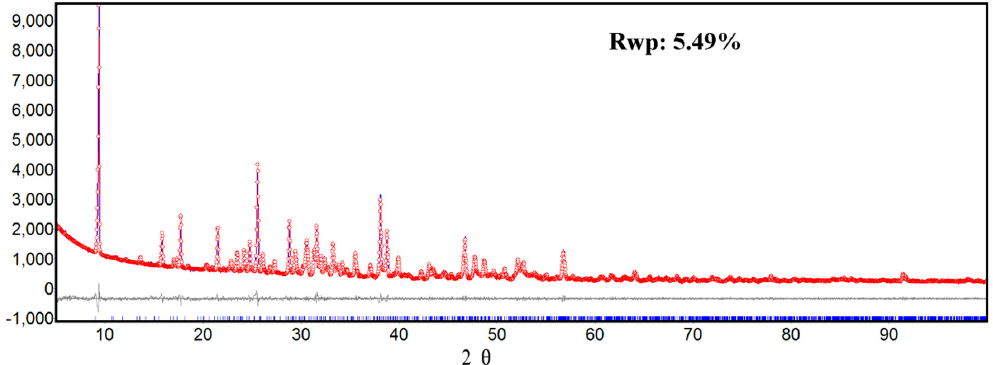
Figure 1. Powder X-ray diffraction patterns of as-synthesized KSb 5 S 8 samples via Rietveld refinement.